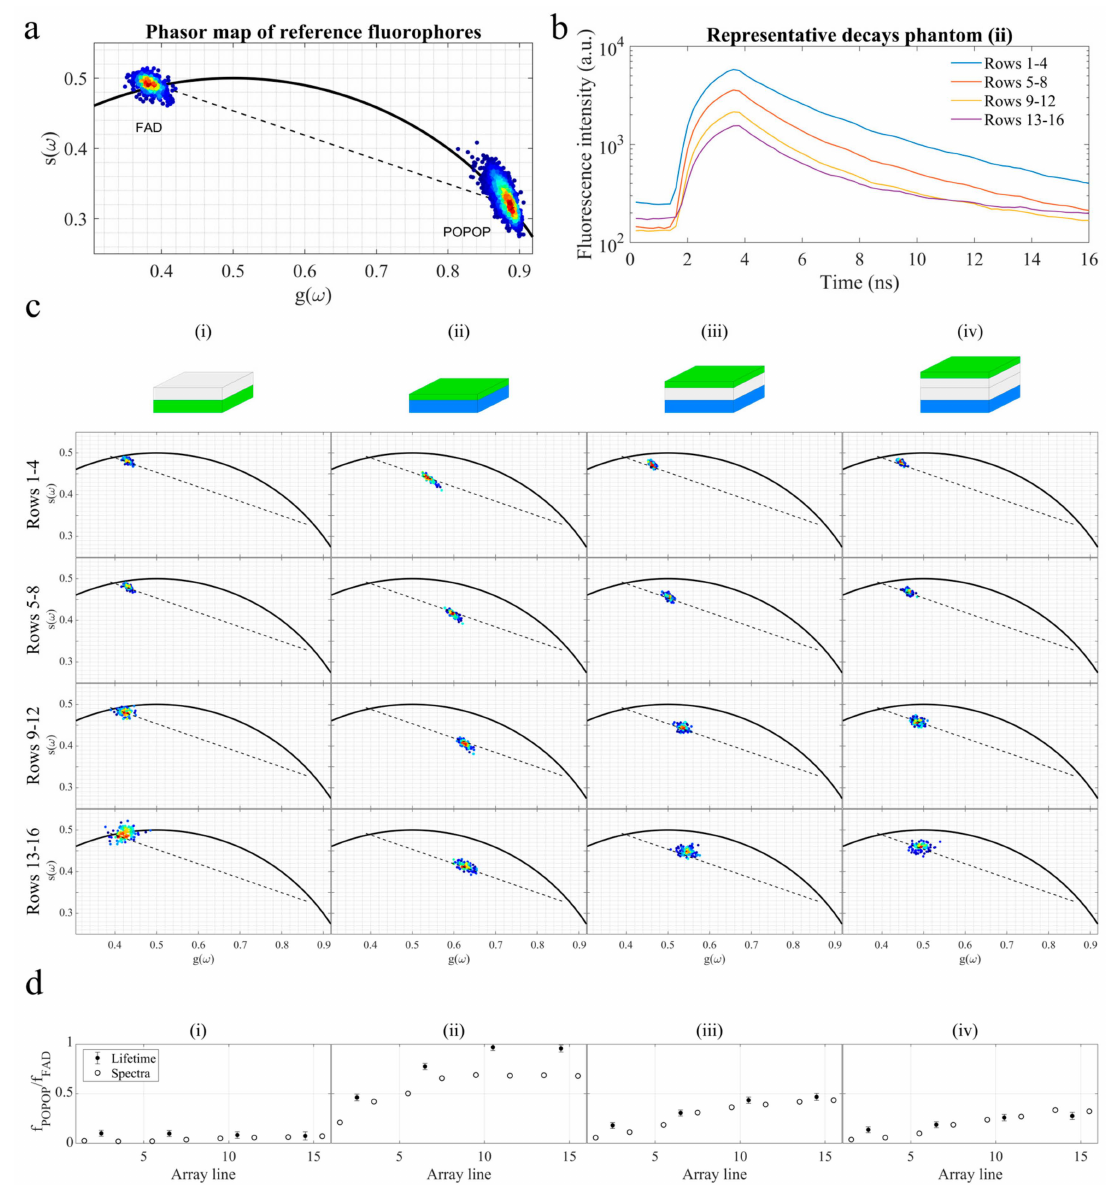
Figure 3. ( a ) A fluorescence lifetime phasor map of FAD and POPOP reference solutions (n = 100 measurements per solution). ( b ) Representative fluorescence intensity decays of phantom (ii) for each group of rows. ( c ) Phasor maps of FAD and POPOP phantoms (n = 100). Columns (i) to (iv) indicate phasor maps of corresponding phantoms as illustrated in Figure 2 and reported on top of each column. Each phasor map shows the phasor transformation of fluorescence decays binned for the rows indicated on the left and for a single spectral channel comprising all columns of the SPAD detector. The black dashed lines connect the center of FAD and POPOP phasor clouds obtained from reference solutions; see Figure 3a. ( d ) The ratio of POPOP to FAD for the top 16 lines of the SPAD array, calculated via lifetime phasors (filled circles) and fluorescence spectral data (empty circles). For lifetime phasors, data were binned for each 4 rows; for spectral data, data were binned for each 2 rows. Ratios closer to 1 indicate a higher contribution of POPOP to the fluorescence